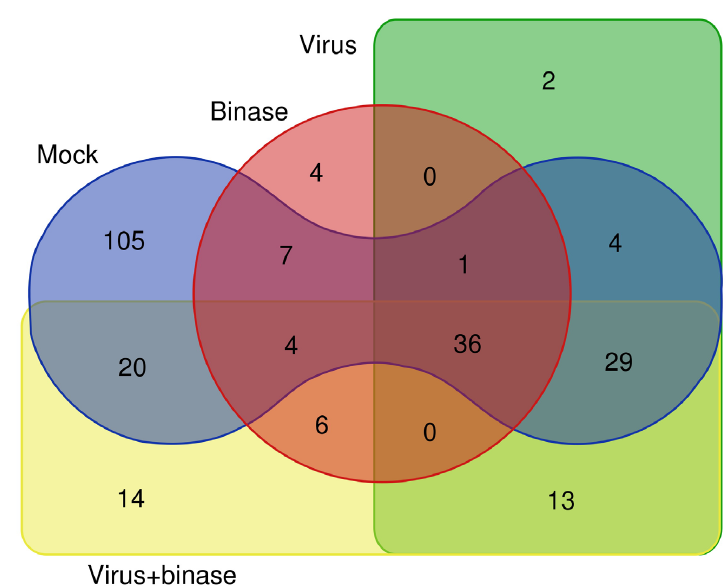
Figure 2. Venn diagram demonstrating the distribution of proteins identified by shotgun liquid chromatography-tandem mass spectrometry (LC-MS / MS) between the total cell fractions of A549 cells upon virus infection and binase treatment (mock-treated, binase-treated, virus-treated, virus and binase-treated, and preincubation scheme of the cell treatment).